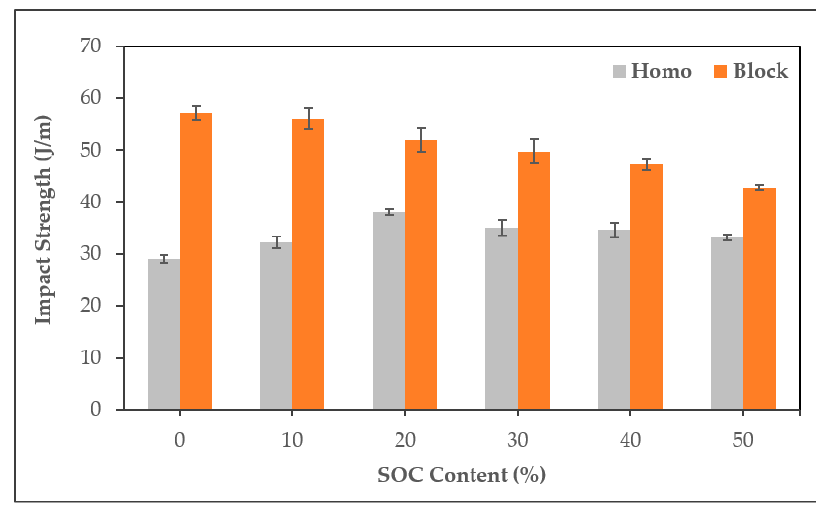
Figure 8. Impact strength of PP/SOC specimen.